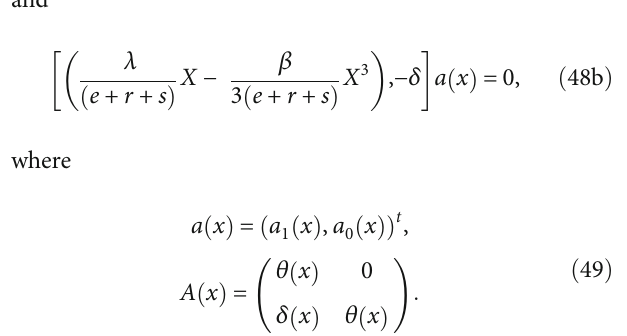
ð x , y , z , t Þ , u ð x , y , t Þ , and u ð x , y , t Þ , of 1 2 3 = 0 : 01 , λ = 0 : 2 , β = 0 : 01 , and α = 0 : 5 1